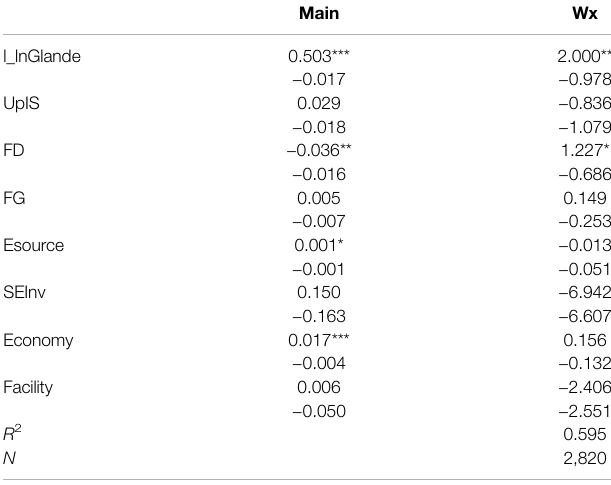
TABLE 7 | Spatial econometrics results of driving factors on